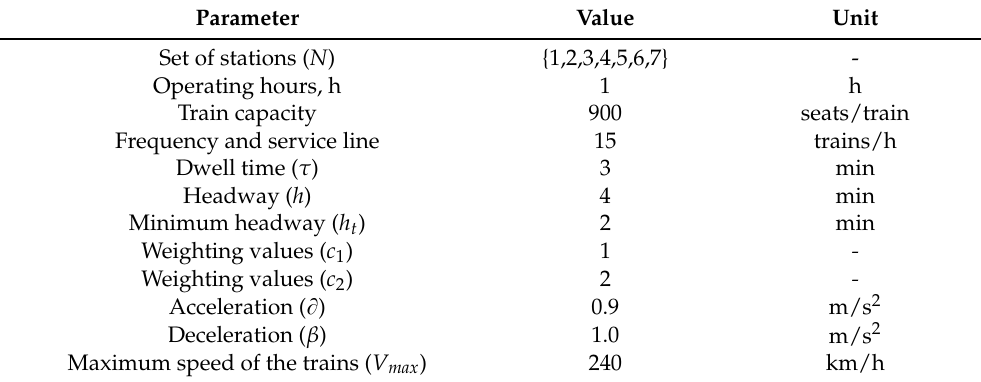
Table 2. Input parameters of case study.